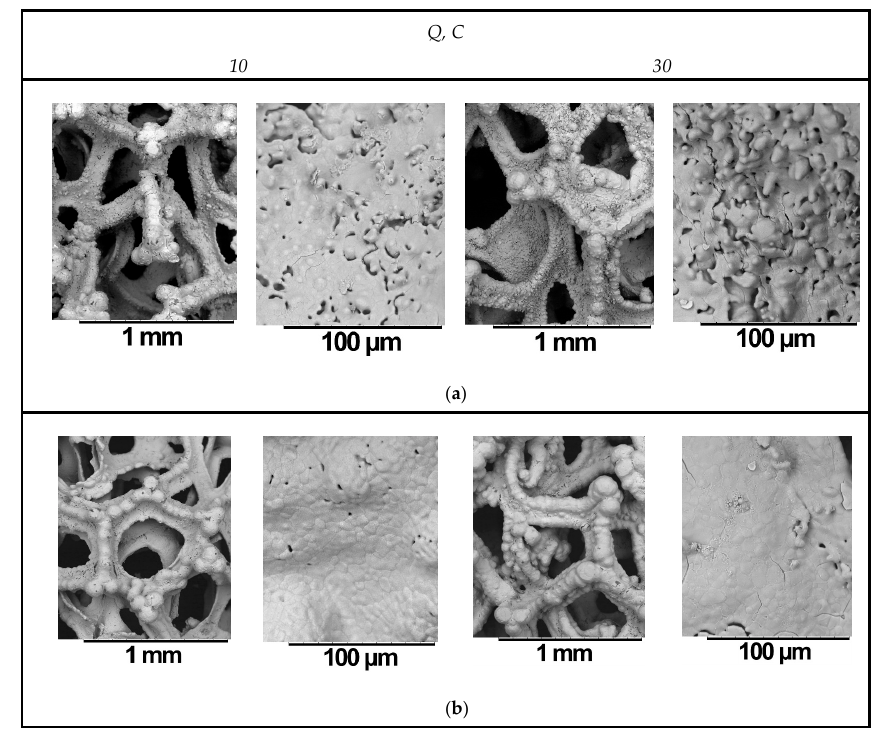
Figure 2. SEM images (low and high magnifications) of electrodeposited MoS2 films at cathodic current of 10 mA on Cu-foam electrodes from electrolytes: ( a ) without sodium hypophosphite; and ( b ) with sodium hypophosphite. Here, Q marks the cathodic charge in coulombs for which the films were electrodeposited (10 and 30